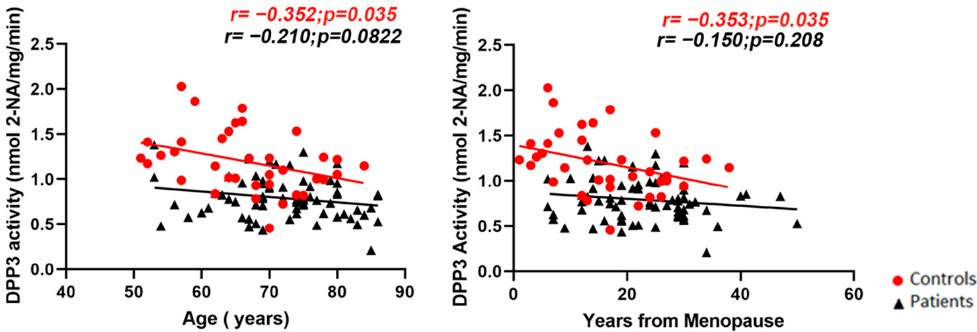
Figure 3. Pearson correlation analysis (two-tail) between age ( left panel) or years from menopause ( right panel) and DPP3 activity in the serum of controls (depicted as red circles, n = 36) and postmenopausal women with severe osteoporosis (depicted as black triangles, n = 69) at baseline.